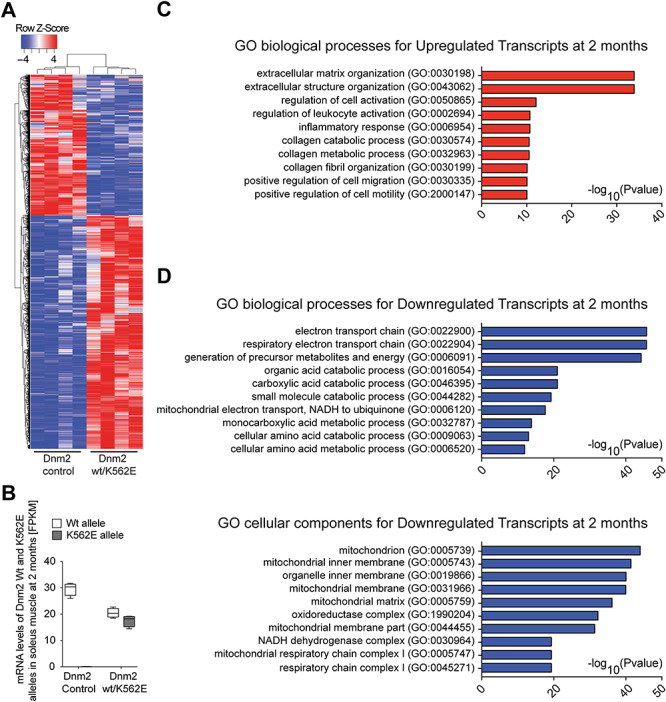
Transcriptome analyses of Dnm2 wt/K562E soleus muscle reveals differential regulation of transcripts consistent with a myopathy. (A) Heatmap of differentially regulated transcripts (FDR < 0.05 and log2 fold change at least ±0.58, approximately ±1.5-fold in linear scale) between control and Dnm2 wt/K562E 2-month-old soleus muscle RNA extracts. Each column represents one mouse. Cluster analysis reveals that control and mutant mice cluster properly with other mice of the same genotype (n = 4 mice/genotype). (B) Box and whiskers plot depicting the number of transcripts (FPKM) expressed by the Dnm2 wild-type and the Dnm2 wt/K562E allele, both in control and Dnm2 wt/K562E soleus muscle at 2 months of age. Each allele produces a similar number of transcripts in Dnm2 wt/K562E soleus samples. Error bars: minimum to maximum range (n = 4 mice/genotype). (C) GO of biological process analysis of upregulated transcripts from Dnm2 wt/K562E versus control soleus (FDR < 0.05 and log2 fold change ≥0.58) reveals that inflammation and ECM organization are among the most significantly represented categories in the dataset (n = 4 mice/genotype). (D) GO of biological processes and GO of cellular components analysis of downregulated transcripts from Dnm2 wt/K562E versus control soleus (FDR < 0.05 and log2 fold change ≤−0.58) reveals that metabolic pathways associated with mitochondrial function, and mitochondria as an organelle, dominate the most significantly represented categories in the dataset (n = 4 mice/genotype).